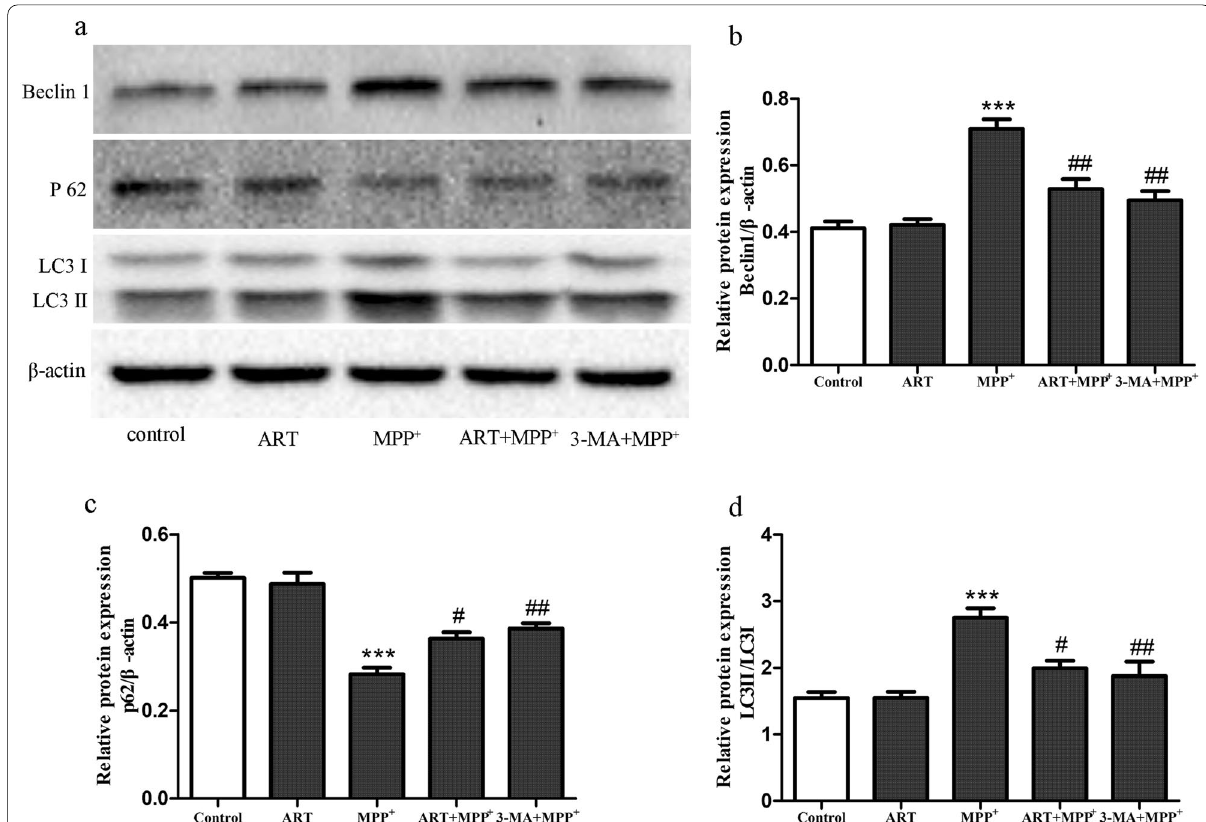
Fig. 5 ART inhibited the autophagy induced by MPP + in SH-SY5Y cells. The protein expression of beclin-1, p62 and LC3 was detected by Western blotting, and β-actin was used as an equal loading control ( a – d ). The data are presented as the mean ## p < 0.01 vs. MPP